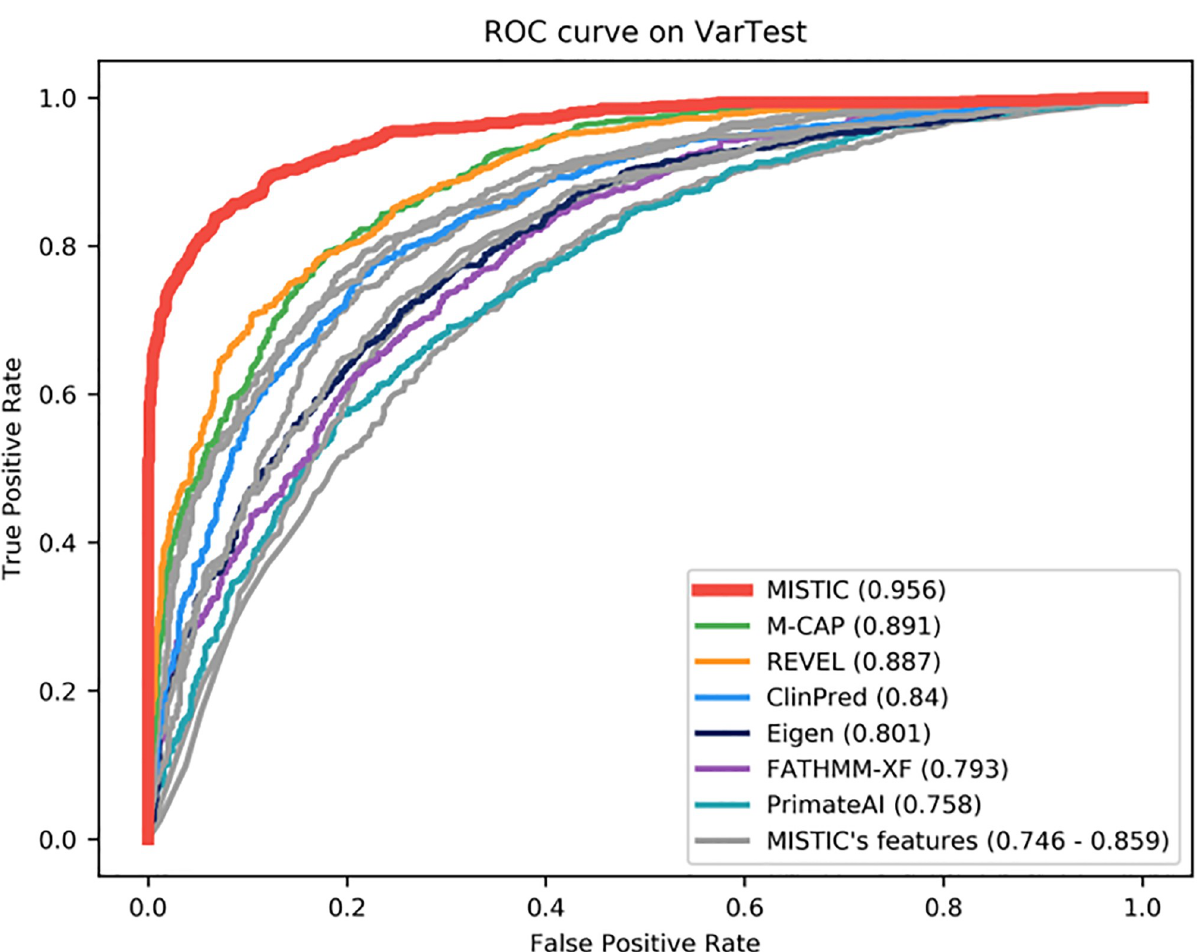
Fig 1. Performance of missense prediction tools on VarTest set. MISTIC was compared to individual component features (MetaSVM, MetaLR, VEST4, Condel, CADD, PolyPhen2, SIFT) used in its model (in grey) and the best-performing tools recently published (in color). The Area Under the receiver operating characteristics Curve (AUC) is shown in